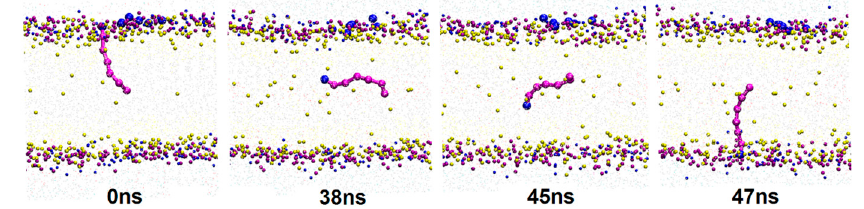
Figure 3. A typical lipid flip-flop process by CG-MD simulations. To show the dynamic process clearly, water and lipid tail beads were hidden in the figures.